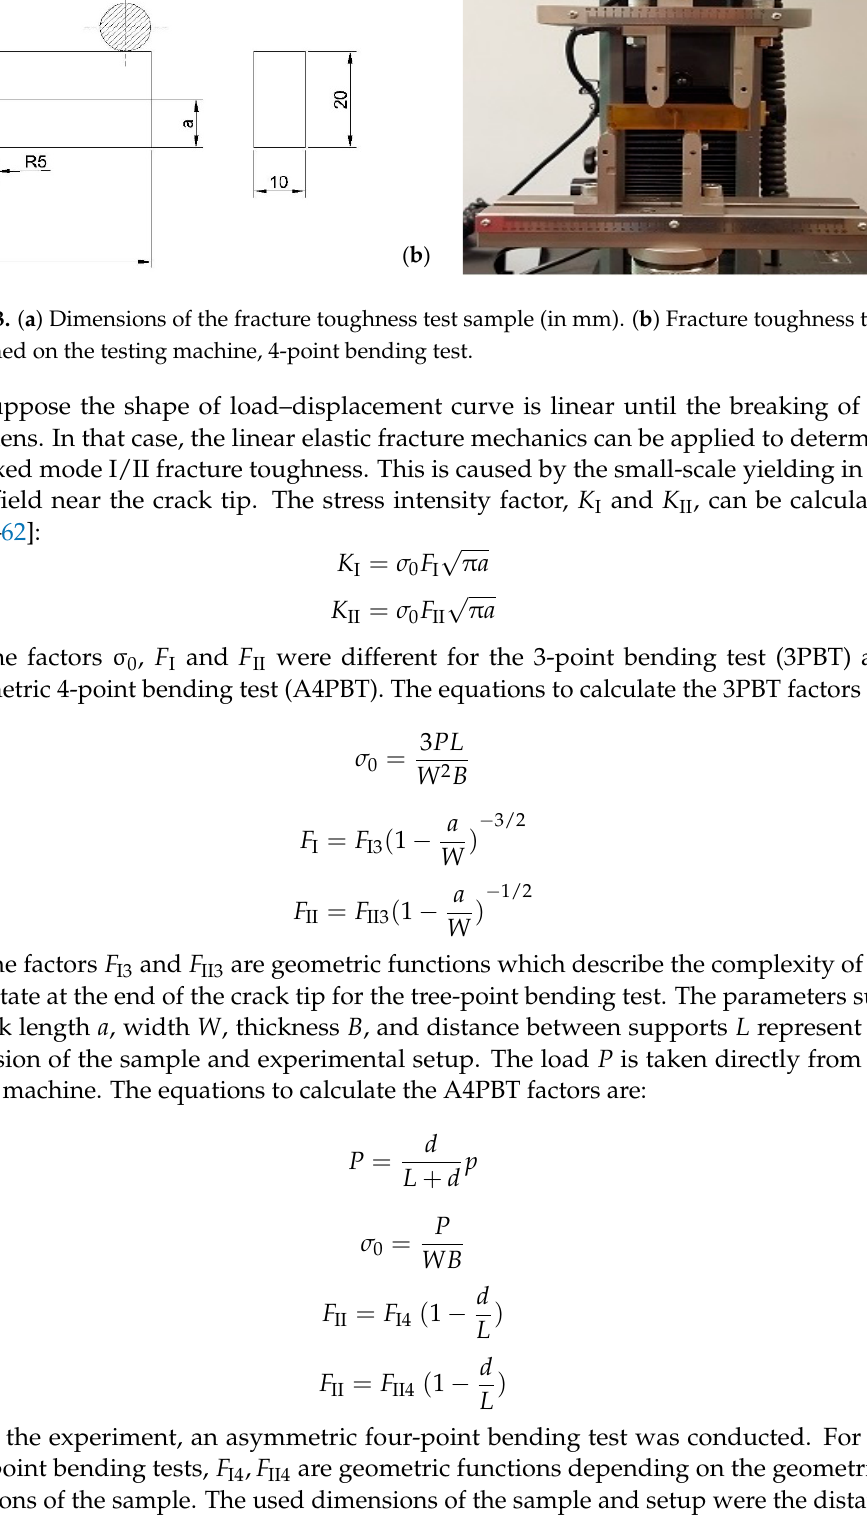
Figure 2. ( a ) Dimensions of the fracture toughness test sample (in mm). ( b ) Fracture toughness tests performed on the testing machine, 3 ‐ point bending test.